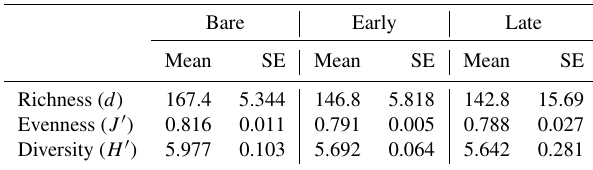
Table 3. Cyanobacterial mean ( ± standard error) of richness (Mar- galef’s index), evenness (Pielou’s index), and diversity (Shannon index) across successional stages. No significant difference in di- versity measures was found between